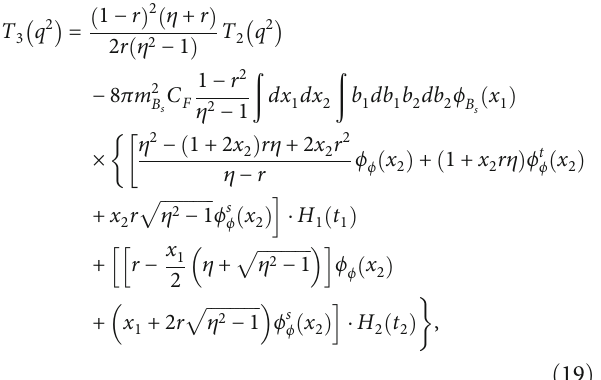
(cid:1)! ϕ ℓ + ℓ − Mode Decays 3. Observables for B s (cid:1) ⟶ ϕ ℓ + ℓ − decay is treated as In experimental analysis, the B s (cid:1) ⟶ ϕ ð ⟶ the four body di ff erential decay distribution B s K + K − Þ ℓ + ℓ − and has been described in terms of the four kine- matic variables [10, 11, 13, 19]: the lepton invariant mass ! = ð cos θ , cos θ , squared q 2 and the three decay angles Ω ℓ K Φ Þ . The angle θ is the angle between the direction of fl ight K of K + and B meson in the rest frame of ϕ , θ ℓ is the s